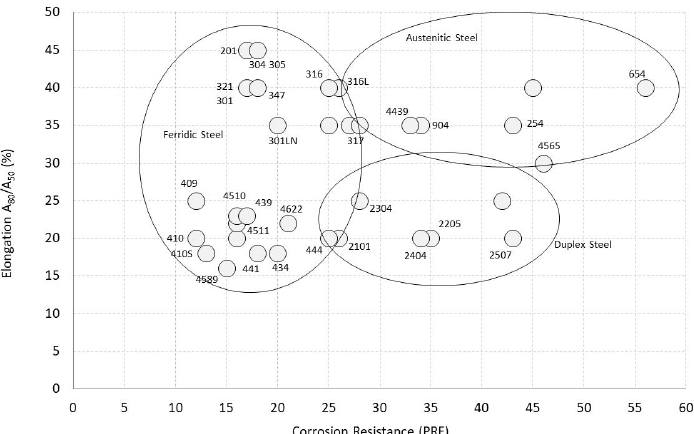
Figure 2. Corrosion resistance (PRE) vs. elongation characteristics (indicative). Reproduced from [29], with permission from Elsevier, 2018.